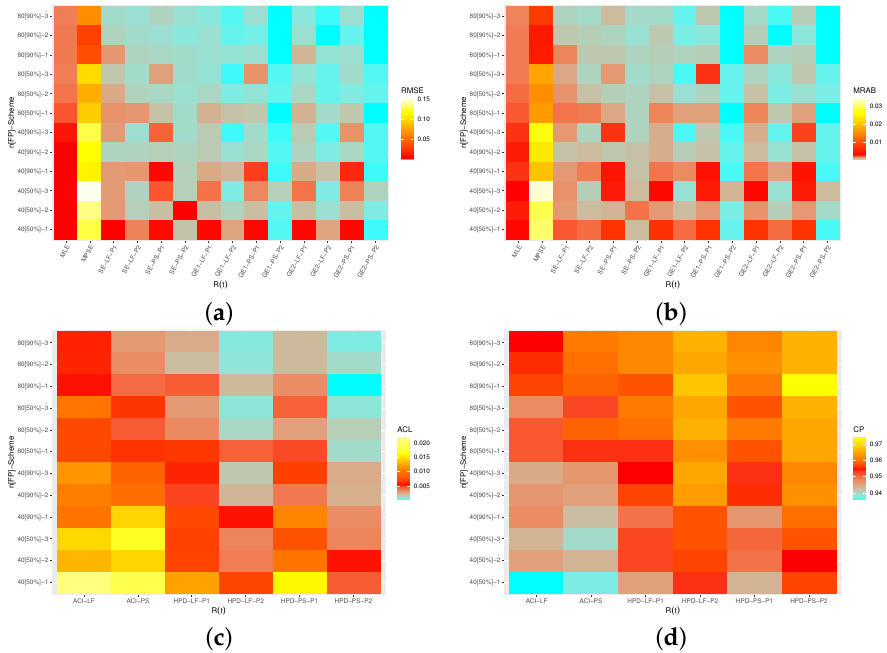
Figure 7. Heatmap for the simulation results of R ( t ) . (a) RMSE. (b) MRAB. (c) ACL. (d) CP.